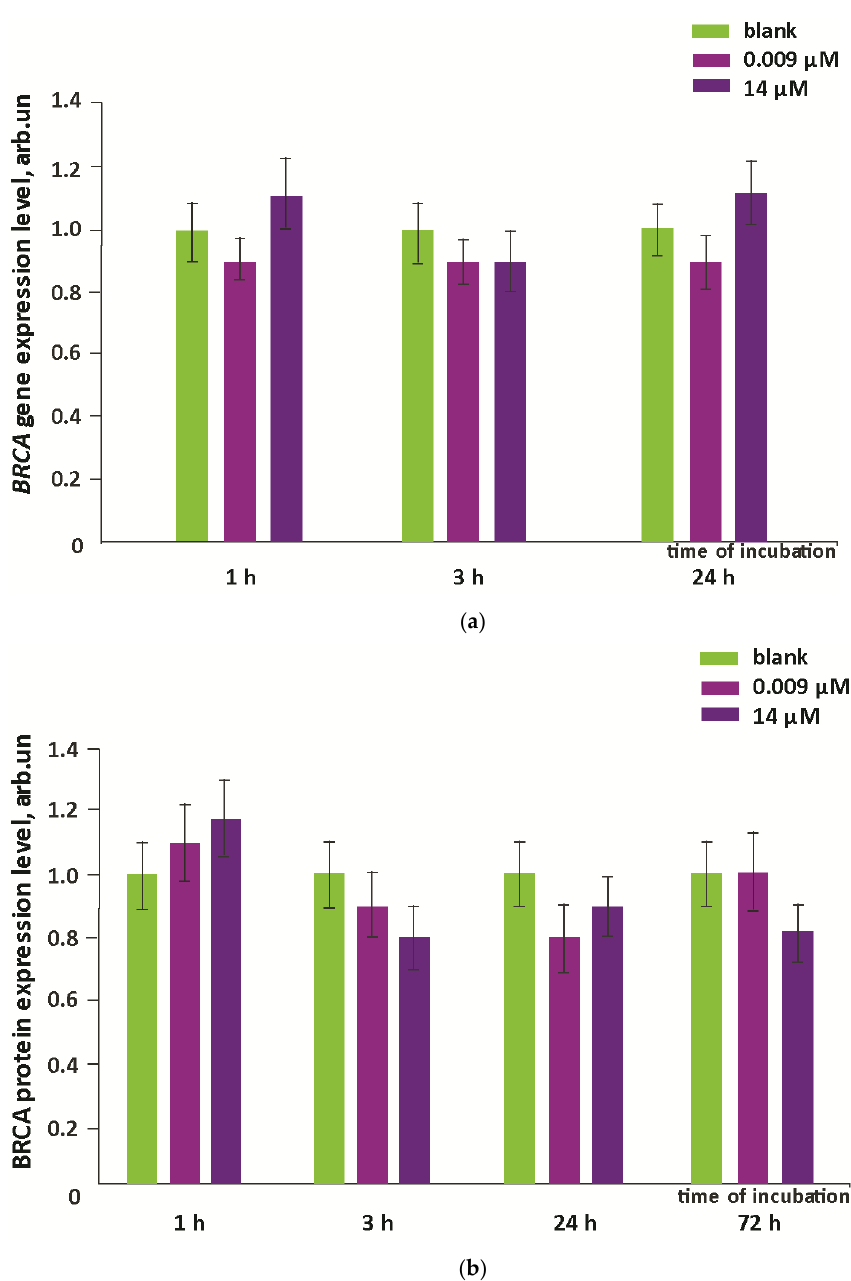
Figure 8. Expression of BRCA1 gene ( a ) and BRCA1 protein ( b ) in HELF cells after incubation with F1 . The amount of BRCA1 RNA is the average of three measurements related to the control values. TBP was used as an internal standard gene. Significant differences with the control by the Mann − Whitney test ( p < 0.01) are denoted by “*”.